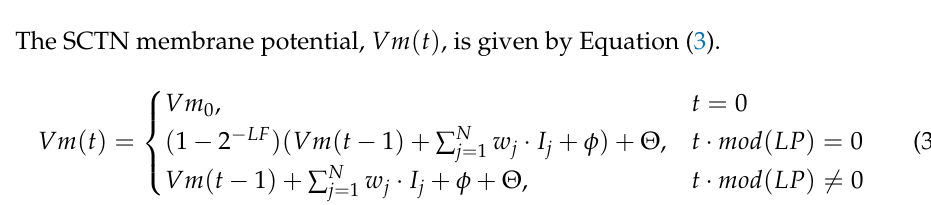
Figure 1. The Spiking Continuous Timing Neuron (SCTN) mathematical